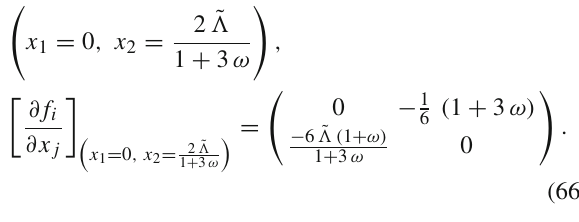
Fig. 6 Saddle-node bifurcation diagram where the dashed curve, x 2 ˜ (cid:4) , determining the fixed points along the x 1 axis. The arrows represent 3 the flow along the x 1 axis !